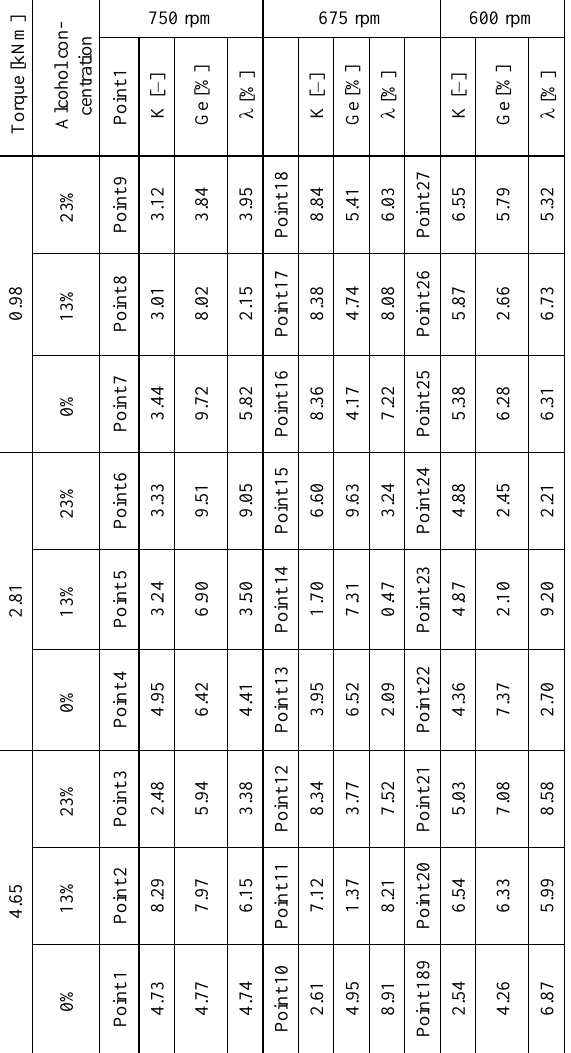
Table 6. Values of measures of adequacy of the mathematical model  hourly fuel consumption in the range from 1.37 to